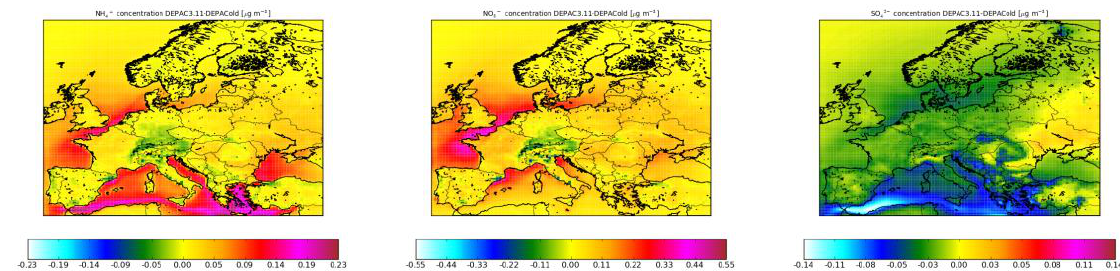
Fig. 14. Absolute difference in the NH + (left), NO − (middle) and SO 2 − (right) concentration due to the use of DEPAC3.11 instead of the Figure 14. Absolute difference in the NH 4+ (left), NO 3- (middle) and SO 42- (right) concentration due to 4 3 4 DEPACold module for the year 2007. The grid resolution of the model results is 0.50 ◦ longitude × 0.25 ◦ latitude ( ∼ 28 × 28km 2 ) the use of 'DEPAC3.11' instead of the 'DEPACold' module for the year 2007. The grid resolution of the model results is 0.50° longitude x 0.25° latitude (~28x28 km 2 ).